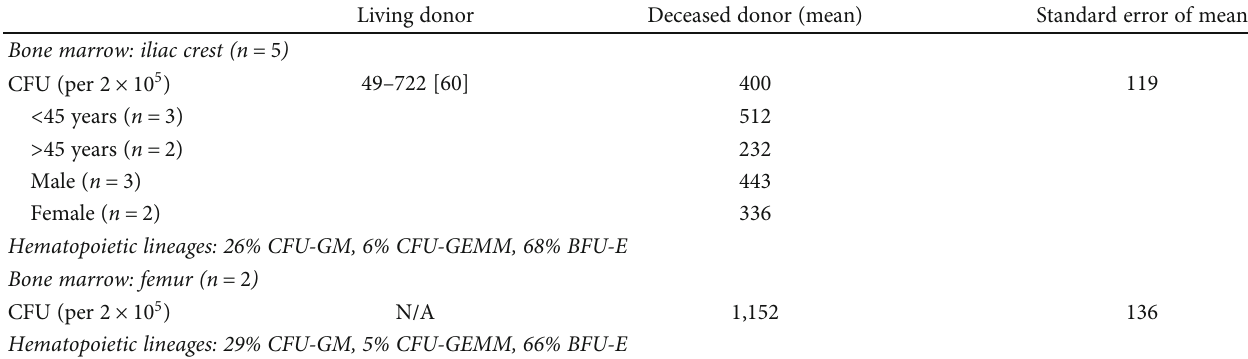
Table 4: Colony-forming units of HSC procured from living and deceased donor bone marrow. Living donor